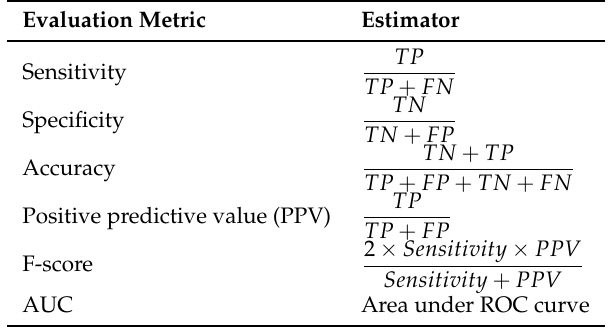
Table 4. Estimators of sensitivity, specificity, accuracy, positive predictive value (PPV), F-score and the area under receiver operating characteristic curve (AUC) in terms of the number of true positive (TP), false positive (FP), true negative (TN) and false negative (FN) classes among the test